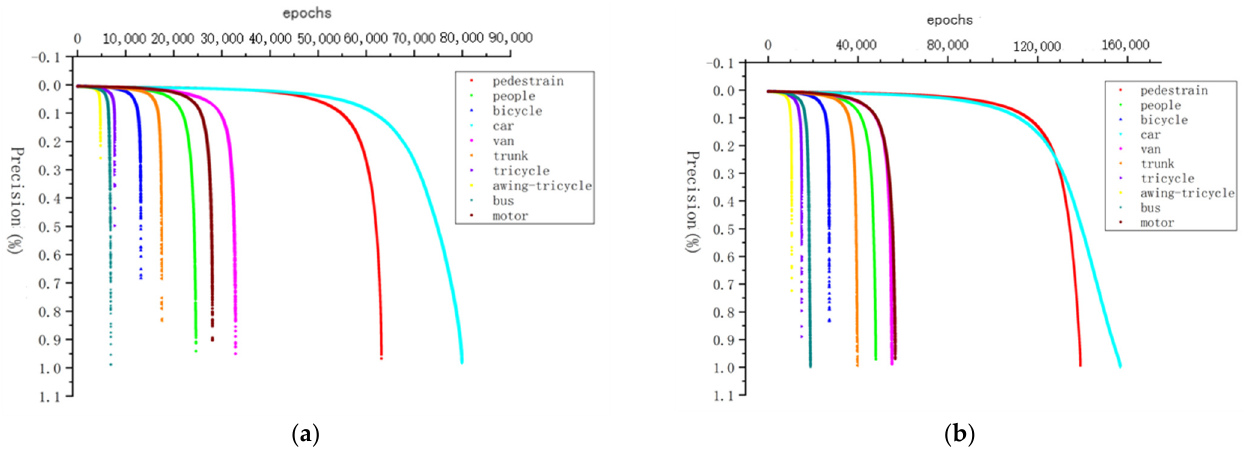
Figure 11. ( a ) The result curve of various target recognition accuracy values under YOLOv3-Tiny network model. ( b ) The right figure is the result curve of various target recognition accuracy values under YOLOv3-Tiny_ReSAM network model.